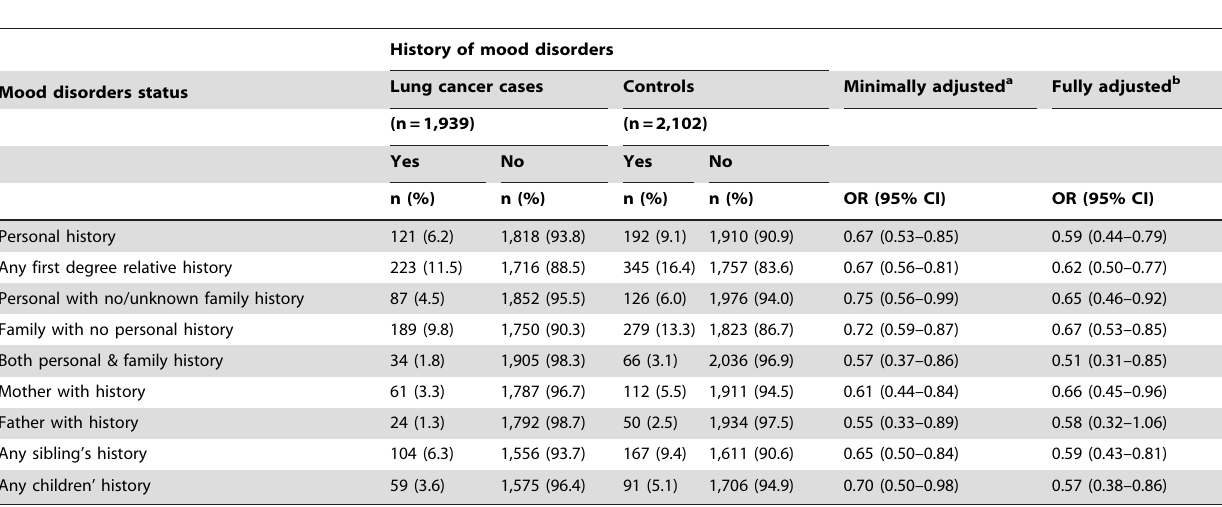
Table 4. Numbers and percentages of cases and controls, and risk estimates for lung cancer by categories of personal or family history in the EAGLE Study, Italy,